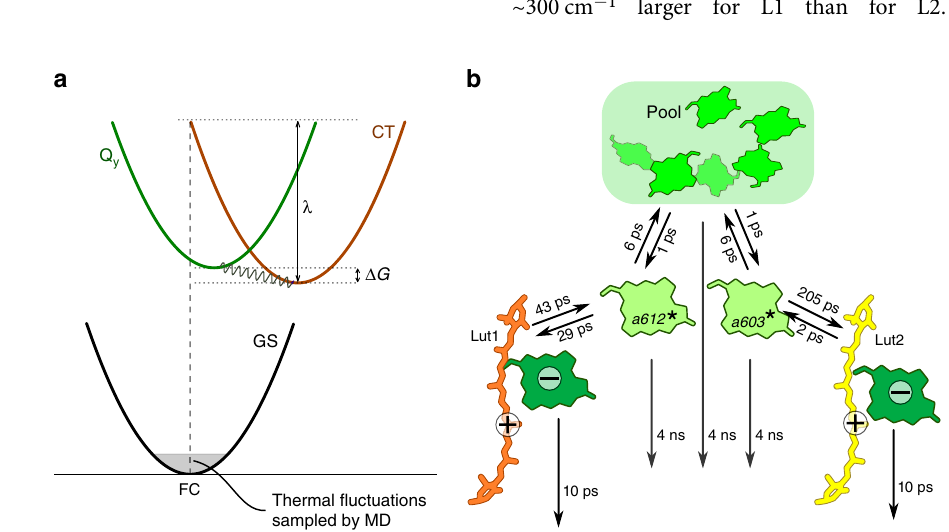
Fig. 2 Model of charge-separation quenching in LHCII. a Scheme of charge separation in the Lut- Chl a dimers, highlighting the relevant parameters that determine the charge-separation rate. The energy minima of Q y and CT states, and the reorganization energy λ , are estimated from the energy fl uctuations along the MD. b Coarse-grained kinetic model of excitation quenching. Numbers besides arrows indicate the inverse rate of the elementary steps. Downward-pointing arrows indicate irreversible decay to the ground